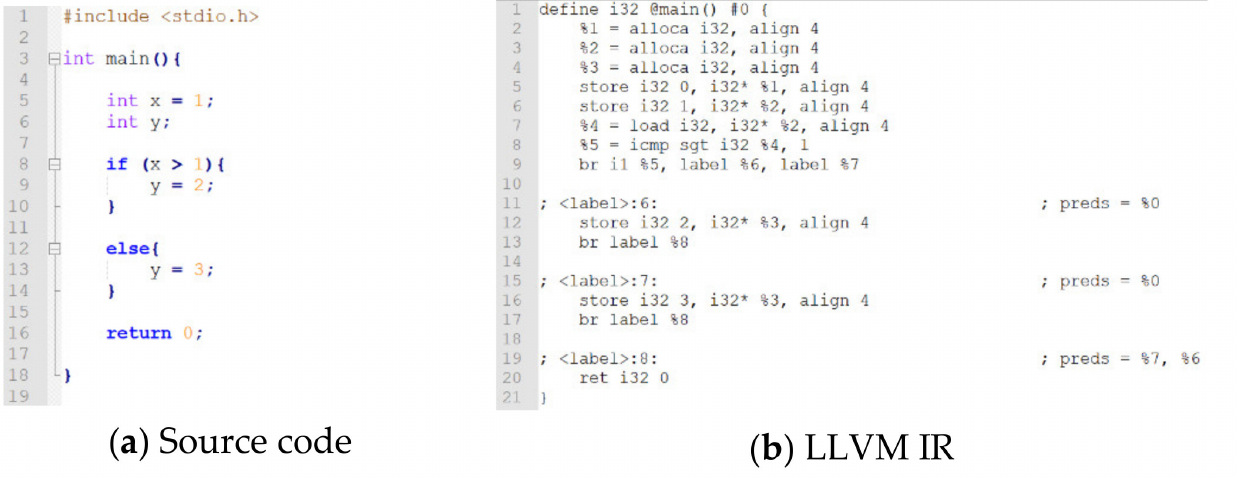
Figure 2. A code snippet and its lower level virtual machine intermediate representation (LLVM IR): ( a ) A program sample written in C language; ( b ) the corresponding LLVM IR form of the program listed in Figure 2a.